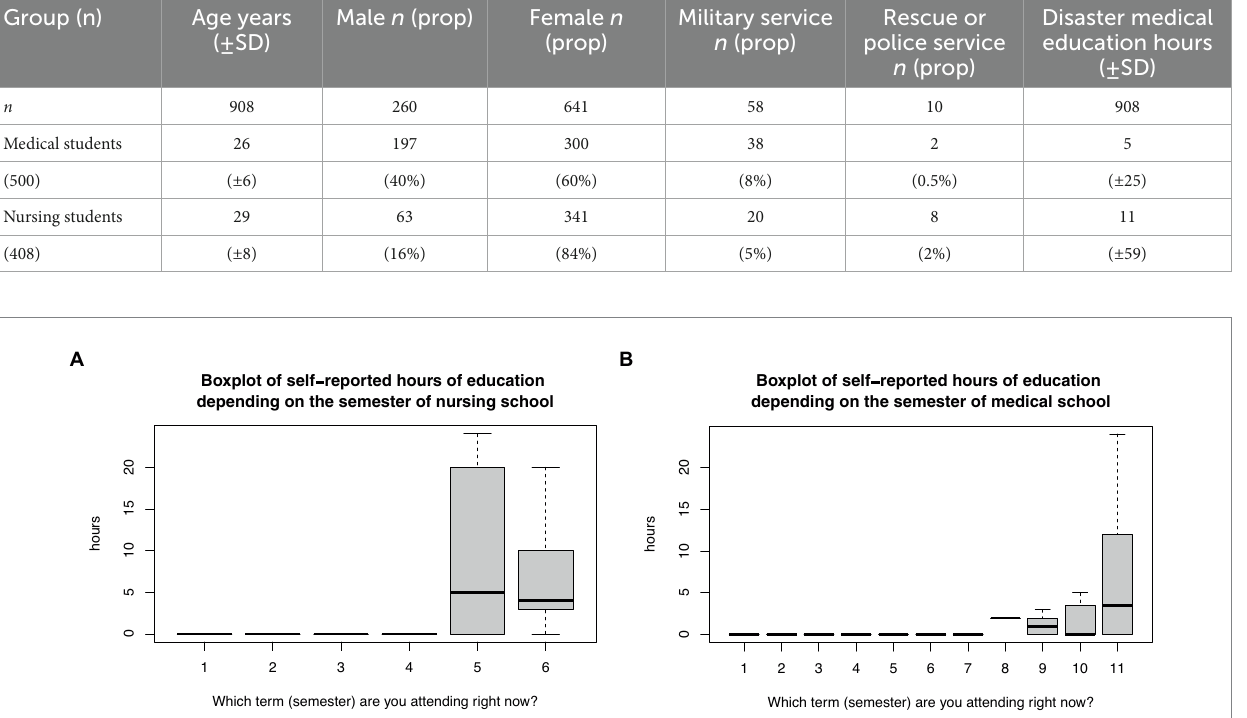
FIGURE 2 Box plot of mean self-assessed disaster medical knowledge base depending on the semester of (A) nursing and (B) medical programs.